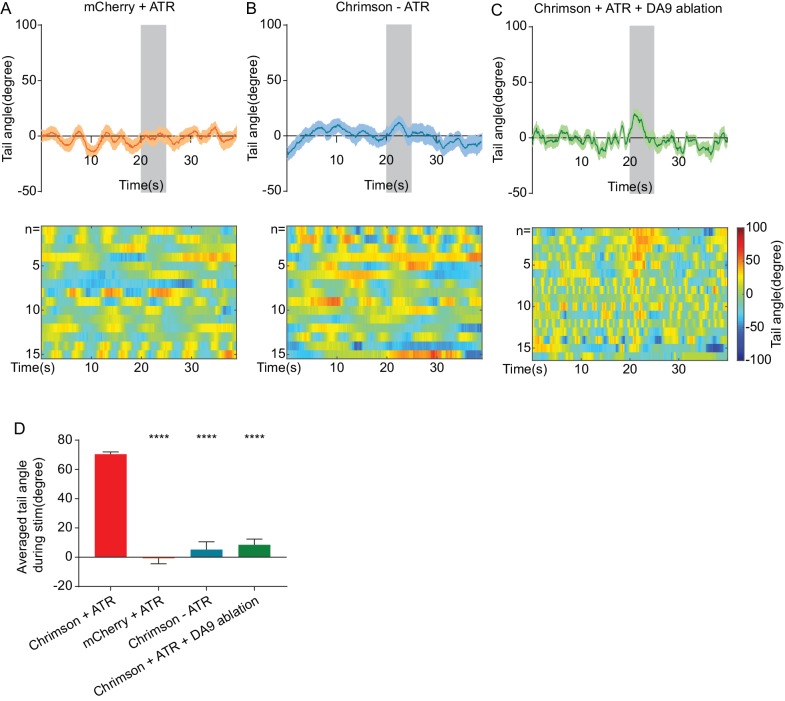
Optogenetically-triggered tail-bending behavior requires Chrimson and ATR and is DA9 specific.(A) ric-7(n2657) animals expressing mCherry instead of Chrimson supplied with ATR show no dorsal tail bending. Mean ± SEM. The shaded area represents the 5 s stimulation. (B) ric-7(n2657) animals expressing Chrimson in the absence of ATR show no dorsal tail bending. Mean ± SEM. The shaded area represents the 5 s stimulation. (C) WT animals expressing Chrimson supplied with ATR but with their DA9 cell body ablated show no dorsal tail bending. Mean ± SEM. The shaded area represents the 5 s stimulation. (D) Averaged tail angle during stimulation of positive controls and animals in (A), (B) and (C). The positive controls are the same as in Figure 4C. Mean and SEM. ****p<0.0001. Unpaired t test.